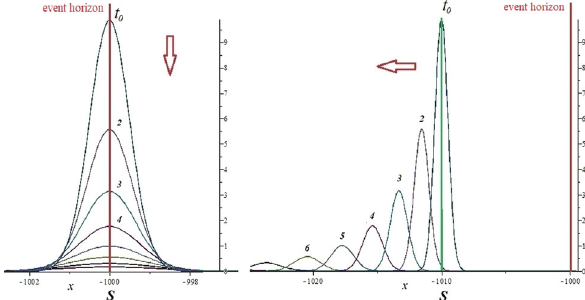
Fig. 5 Horizon effects produced by the event horizon of the de Sitter space-timewhichtrapsthepacketspreparedonitandreflectsthepackets prepared beyond it. Consecutive profiles of the intensity are plotted in both cases in a logarithmic